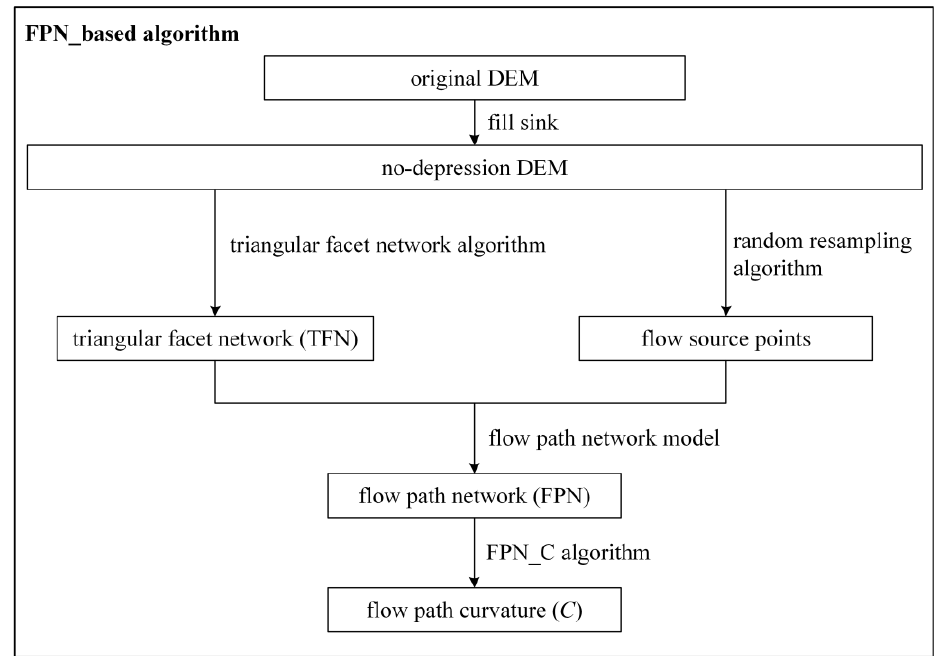
Figure 1. Flow chart of the flow path network (FPN)-based algorithm for computing C .